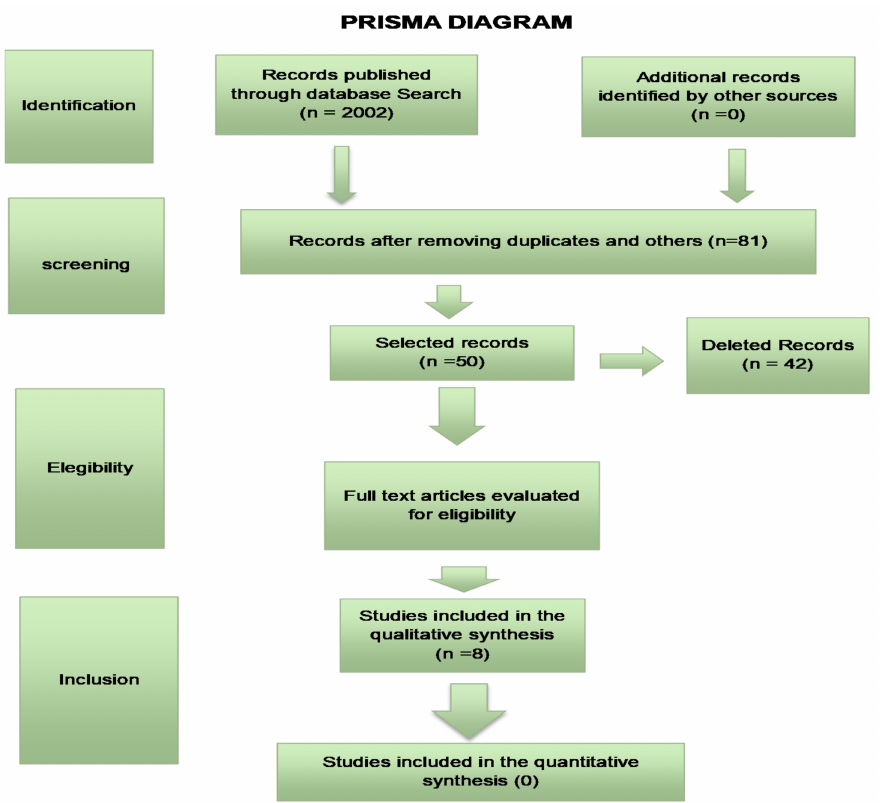
Figure 2. PRISMA diagram according to Bibliographic